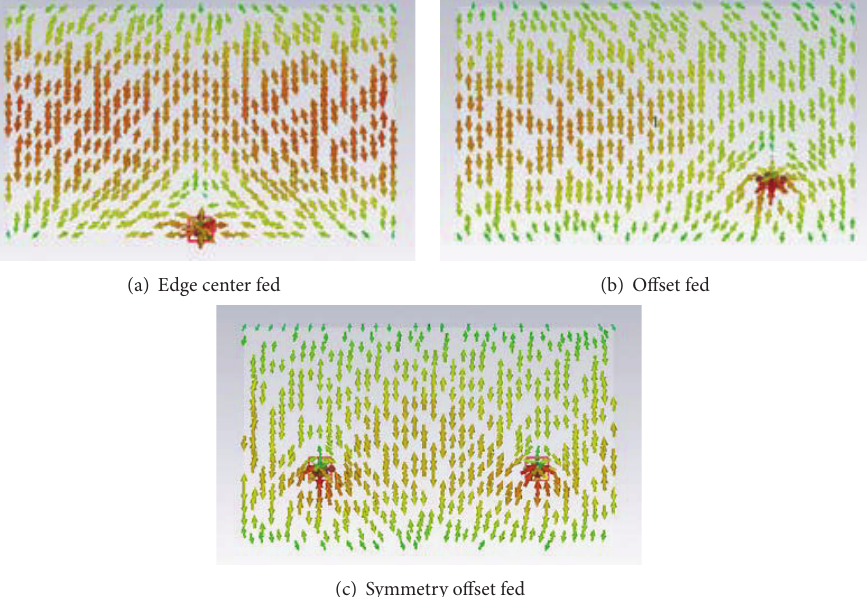
Figure 9: Surface currents of antennas with different feeding